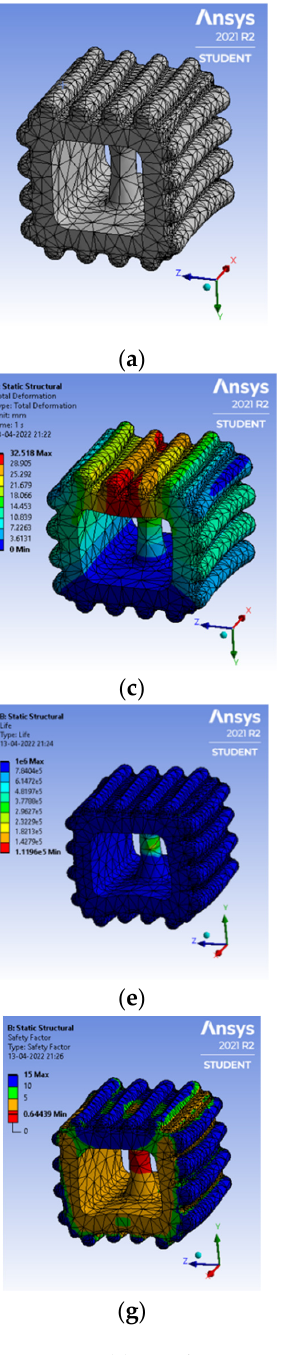
Figure 16. ( a ) Mesh generation; ( b ) Loads and boundary conditions; ( c ) Total deformation; ( d ) Von mises stress; ( e ) Life cycle; ( f ) Damage; ( g ) Factor of safety; ( h ) Biaxiality